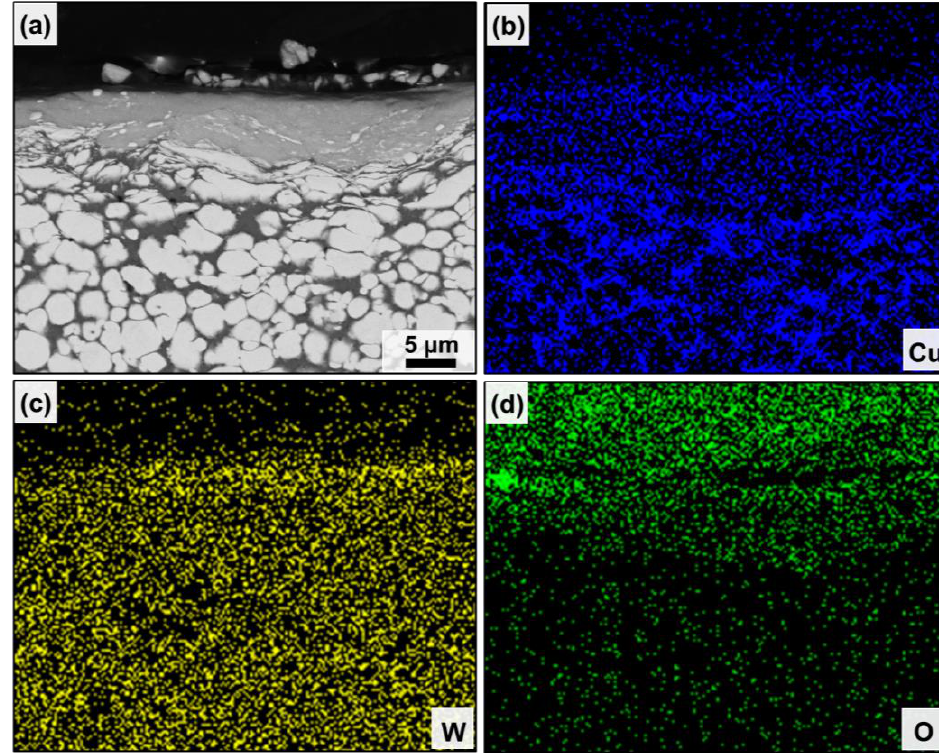
Figure 5. SEM images of worn surfaces ( a – c ) and cross-sectional microstructure under the wear scar ( d ) of the UFG W – Cu composite.